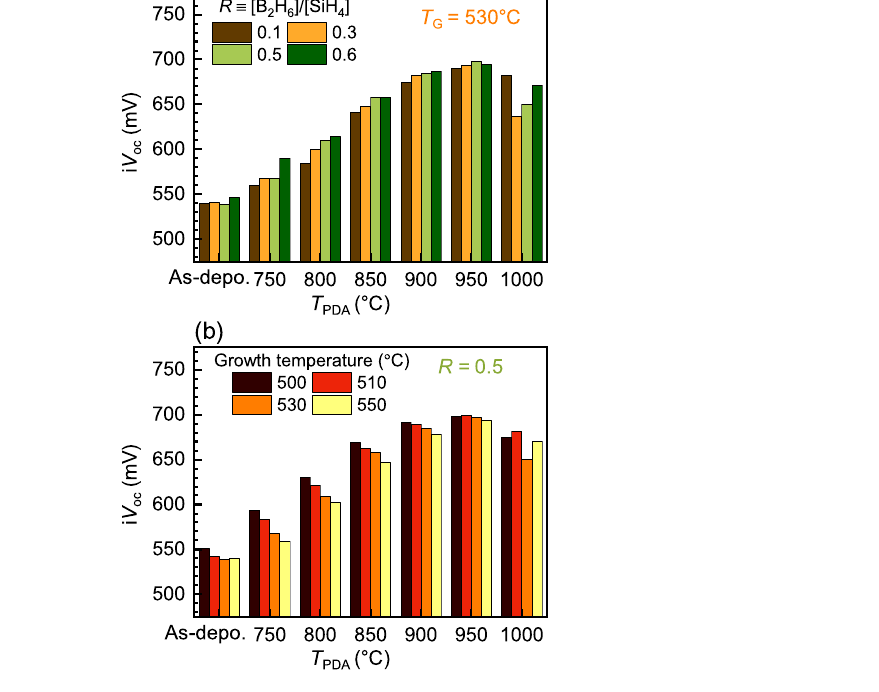
Figure 4. Thermal annealing effect on passivation at different poly-Si growth conditions. Measured i V OC values in as-deposited states and after thermal annealing based on the ( a ) flow rate ratio of B 2 H 6 and SiH 4 precursor gases and ( b ) growing temperature